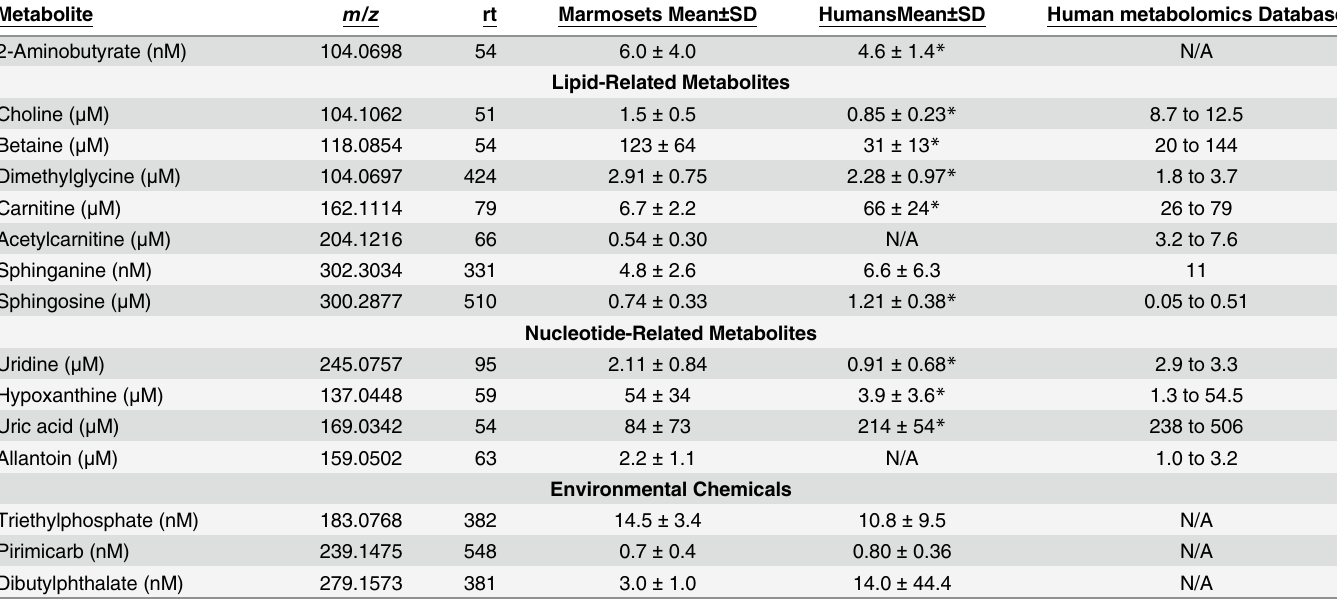
Plasma metabolites of common marmosets (n = 50) quanti fi ed by LC-MS are included along with measures for human plasma (n = 80) obtained with the same method. Ranges of concentrations of metabolites in human plasma reported by HMDB are also included for comparison. ( m/z , mass-to-charge, rt, retention time). N/A, data not